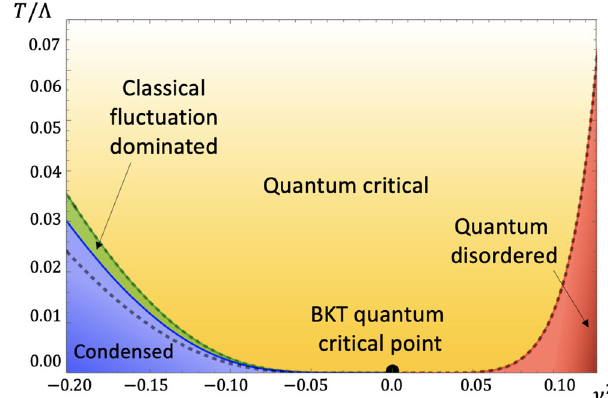
Fig. 2 Phase diagram of the SYK model. Phase diagram as a function of temperature T and ν 2 de fi ned in Eq. (10) with γ = 0.9. The susceptibility diverges at the transition temperature T c (solid line) that vanishes in a BKT-like fashion at ν 2 = 0. Below T c we have superconducting order (blue). Between the dashed lines we fi nd classical critical behavior with Curie – Weiss susceptibility and critical slowing down χ (cid:6) t dyn (cid:6) ð T (cid:3) T c Þ (cid:3) 1 (we only calculated the upper dashed curve, the lower one is an educated guess). As the susceptibility is fi nite at the BKT quantum critical point, quantum criticality is identi fi ed by the regime where ∂ T χ ð T Þ (cid:6) 1 = ð T log 2 T Þ (yellow region). In the quantum-disordered region (red) ∂ T χ ( T ) saturates as T → 0. The quantum critical and quantum-disordered regimes are separated by a crossover.